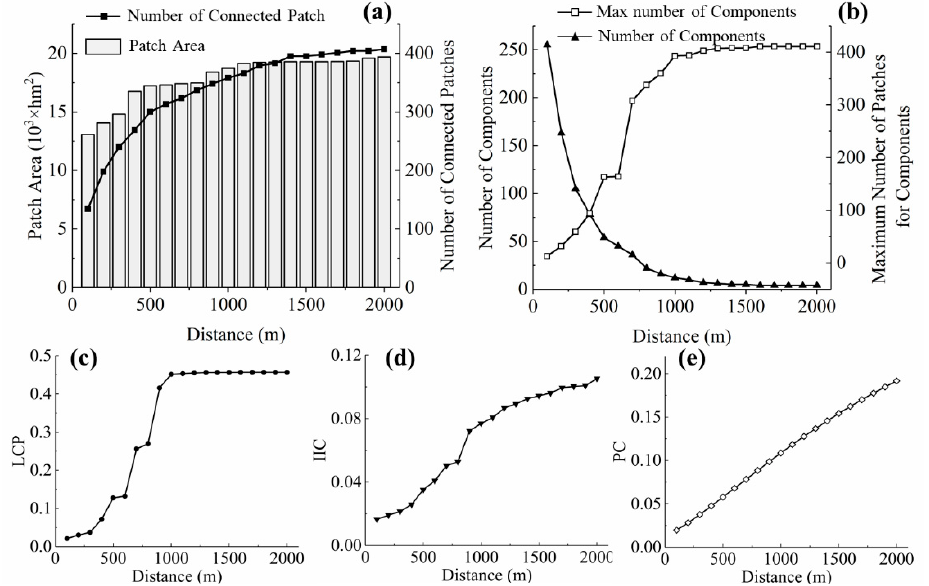
Figure 7. The variation in landscape connectivity indices under different distance thresholds using Conefor 2.6: ( a ) connected patch area and number of patches; ( b ) number of components and maximum number of patches for components; ( c ) landscape connectivity probability (LCP); ( d ) integral index of connectivity (IIC); and ( e ) probability index of connectivity (PC).